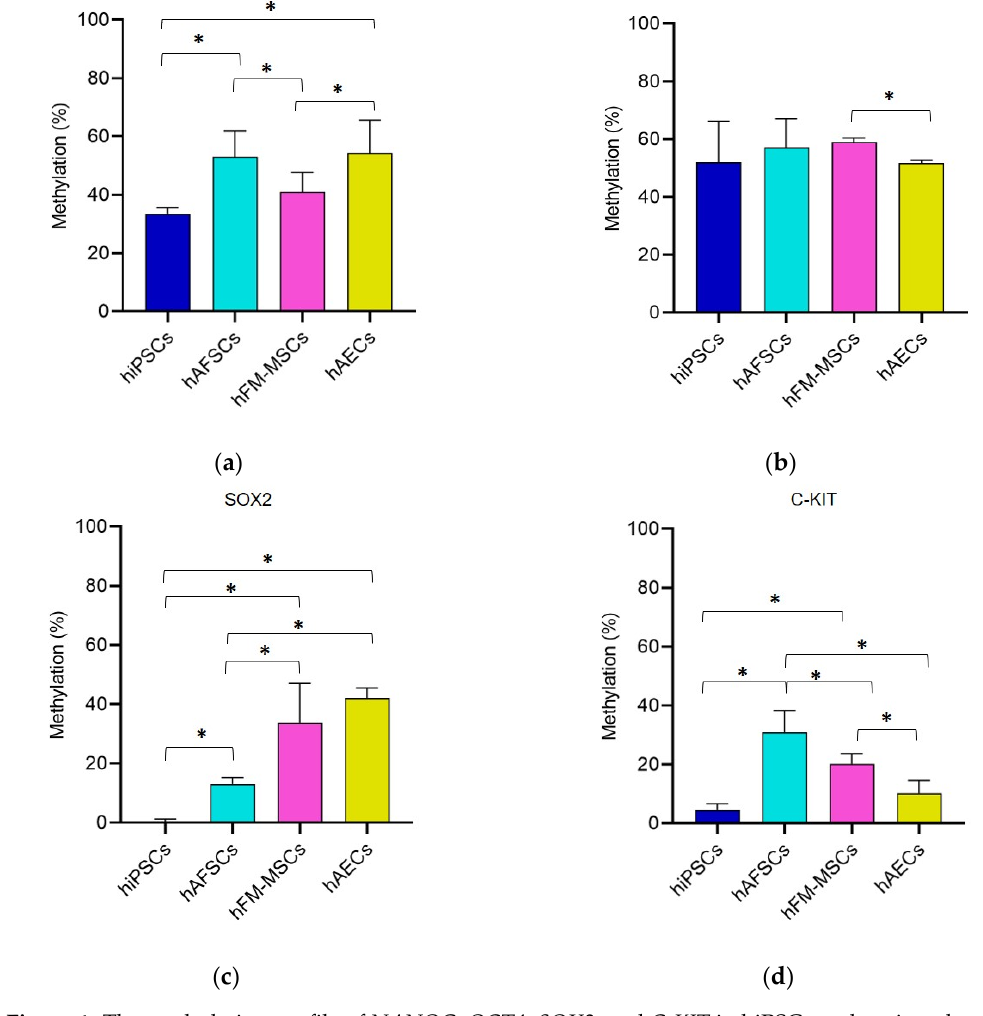
Figure 1. The methylation profile of NANOG, OCT4 , SOX2 , and C ‐ KIT in hiPSCs and perinatal stem cells (SCs). Pyrosequencing results showed the percentage of methylation levels in the promoter region of ( a ) NANOG , ( b ) OCT4 , ( c ) SOX2 , and ( d ) C ‐ KIT in SCs from different sources. The graphs show the mean ± SD of 5 independent experiments, * p < 0.05.